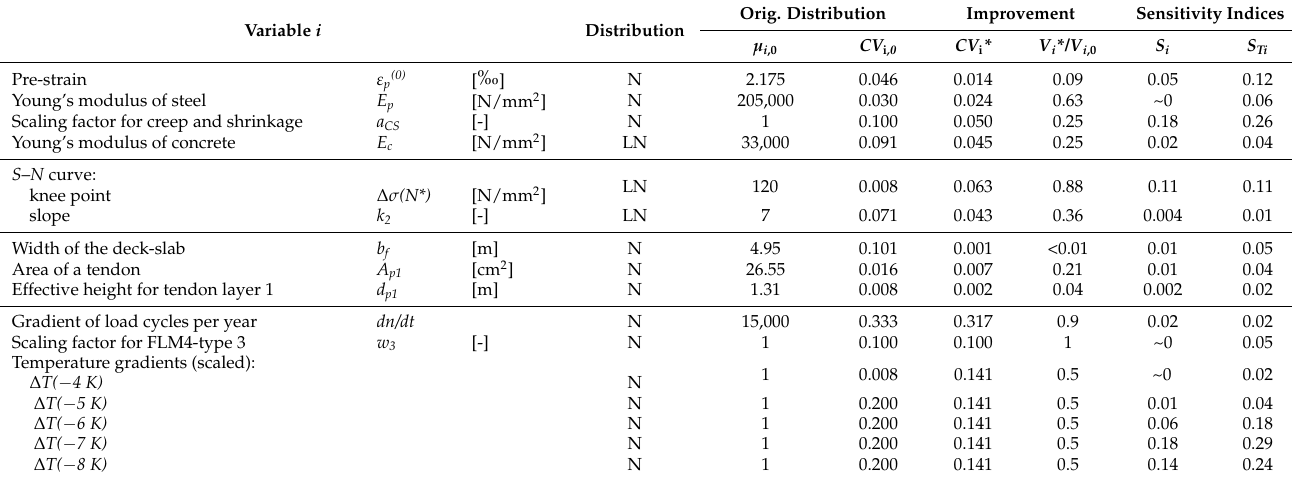
Table 1. Stochastic variables with initial (original) distribution characteristics ( µ i,0 , σ i,0 ) and reduced variances ( σ i * ), as well as Sobol’s sensitivity indices.